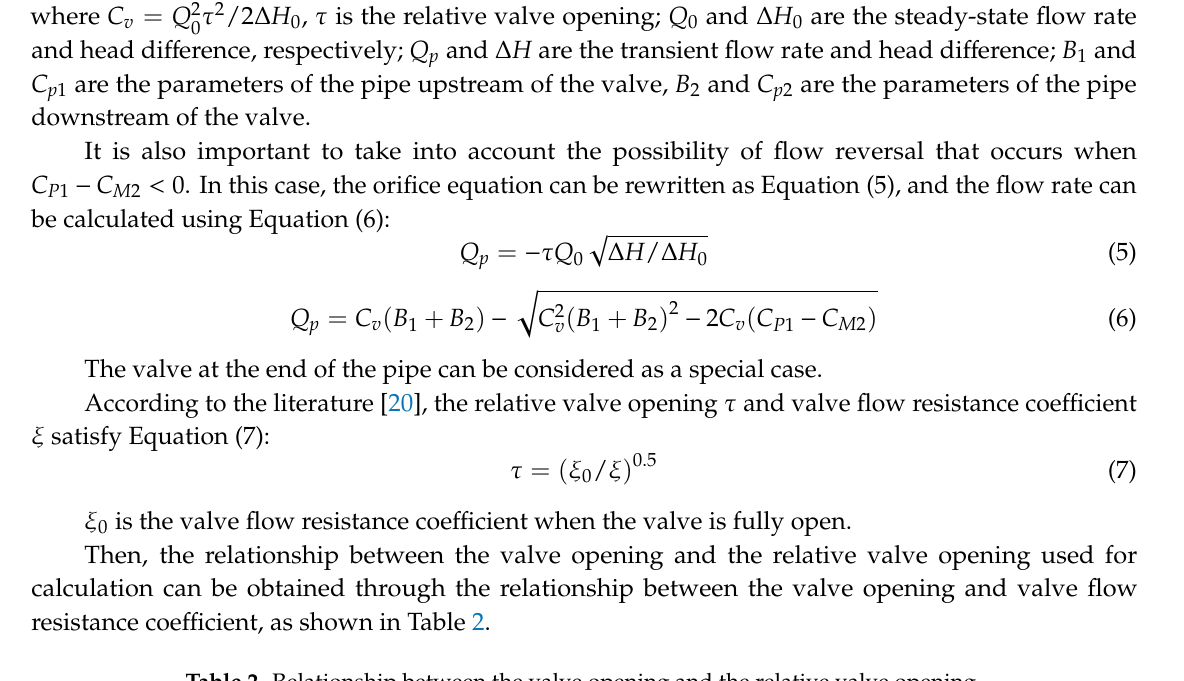
Table 2. Relationship between the valve opening and the relative valve